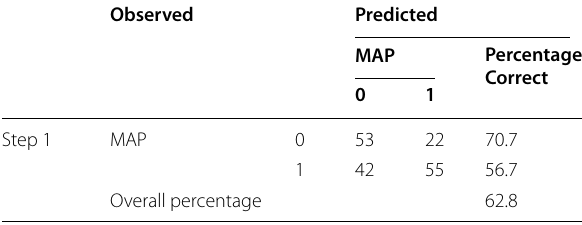
Table A1: Classification table for teamwork culture